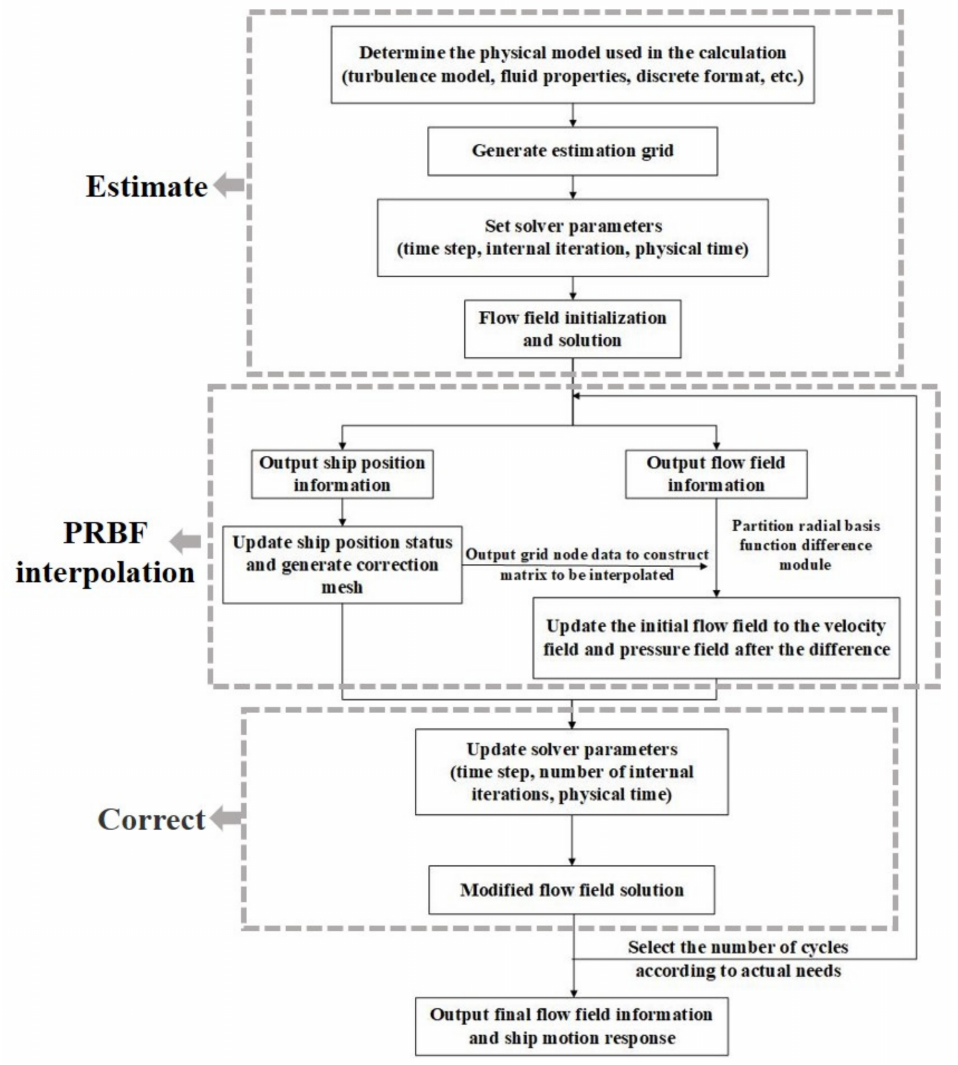
Figure 3. Flow chart of the fast algorithm of the CMG method combined with the PRBF approach. The simulation started from a numerical wave tank with a coarse background